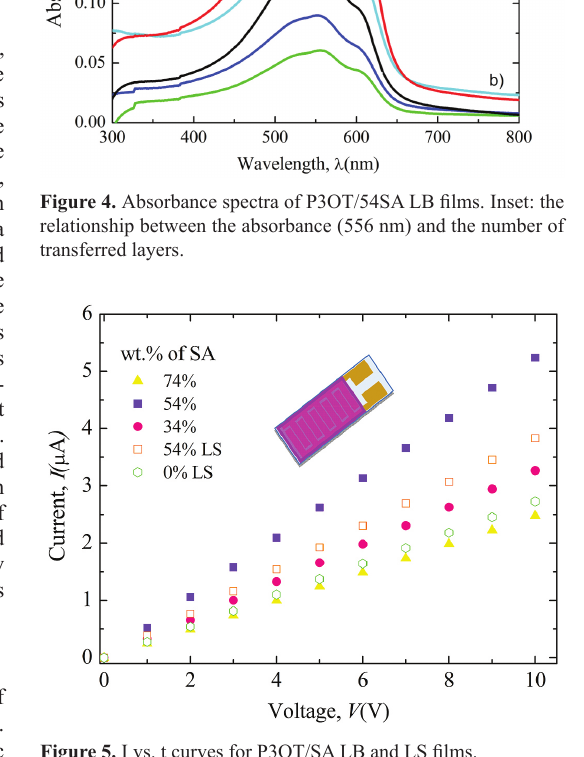
Figure 5. I vs. t curves for P3OT/SA LB and LS